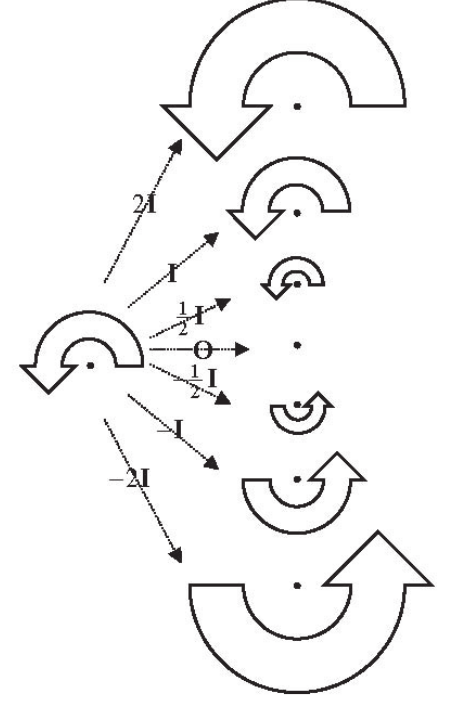
Figure 3 Some scalar magnifications. Identity